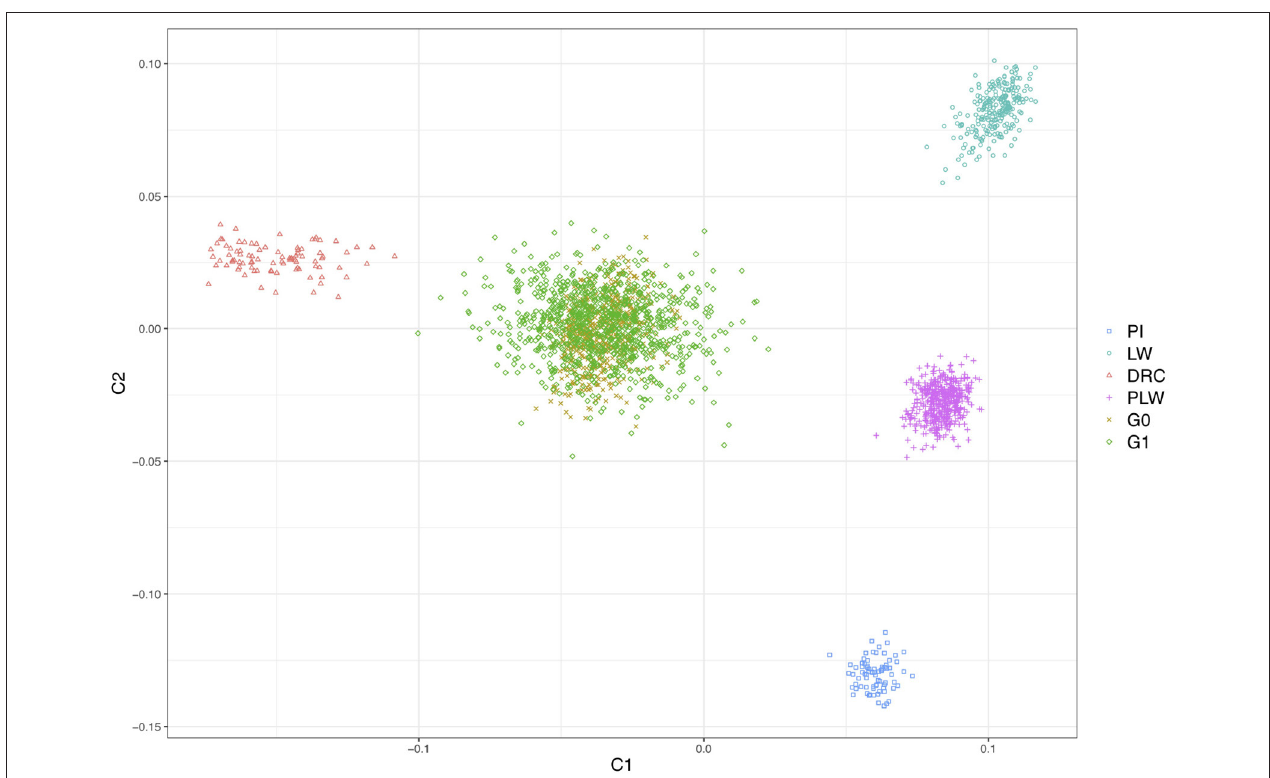
FIGURE 2 | Population structure shown in a multidimensional scaling analysis (MDS) plot of all animals. DRC, Duroc; G0, (Pietrain × Large White) × Duroc offspring; G1, G0 × G0 offspring; LW, Large White; PI, Pietrain; PLW, Pietrain × Large